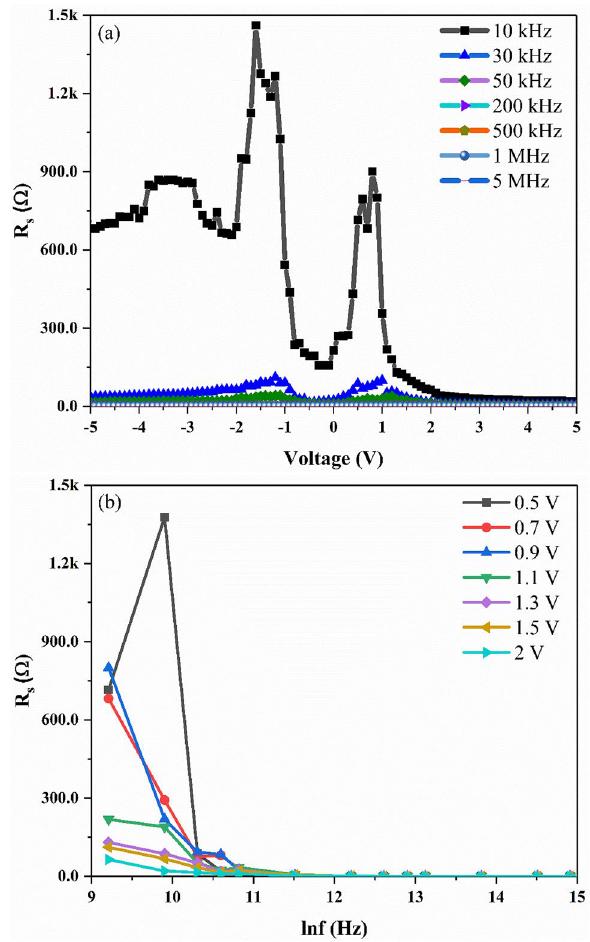
Figure 3. Plots of ( a ) R s –V and ( b ) R s -lnf for the Ag/TiO 2 -NW/Ge-NW/Si (MOS)